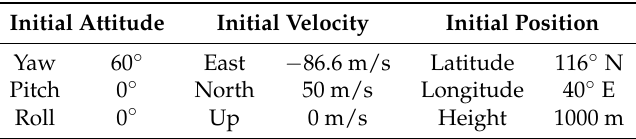
Table 1. The specifications of simulated flight